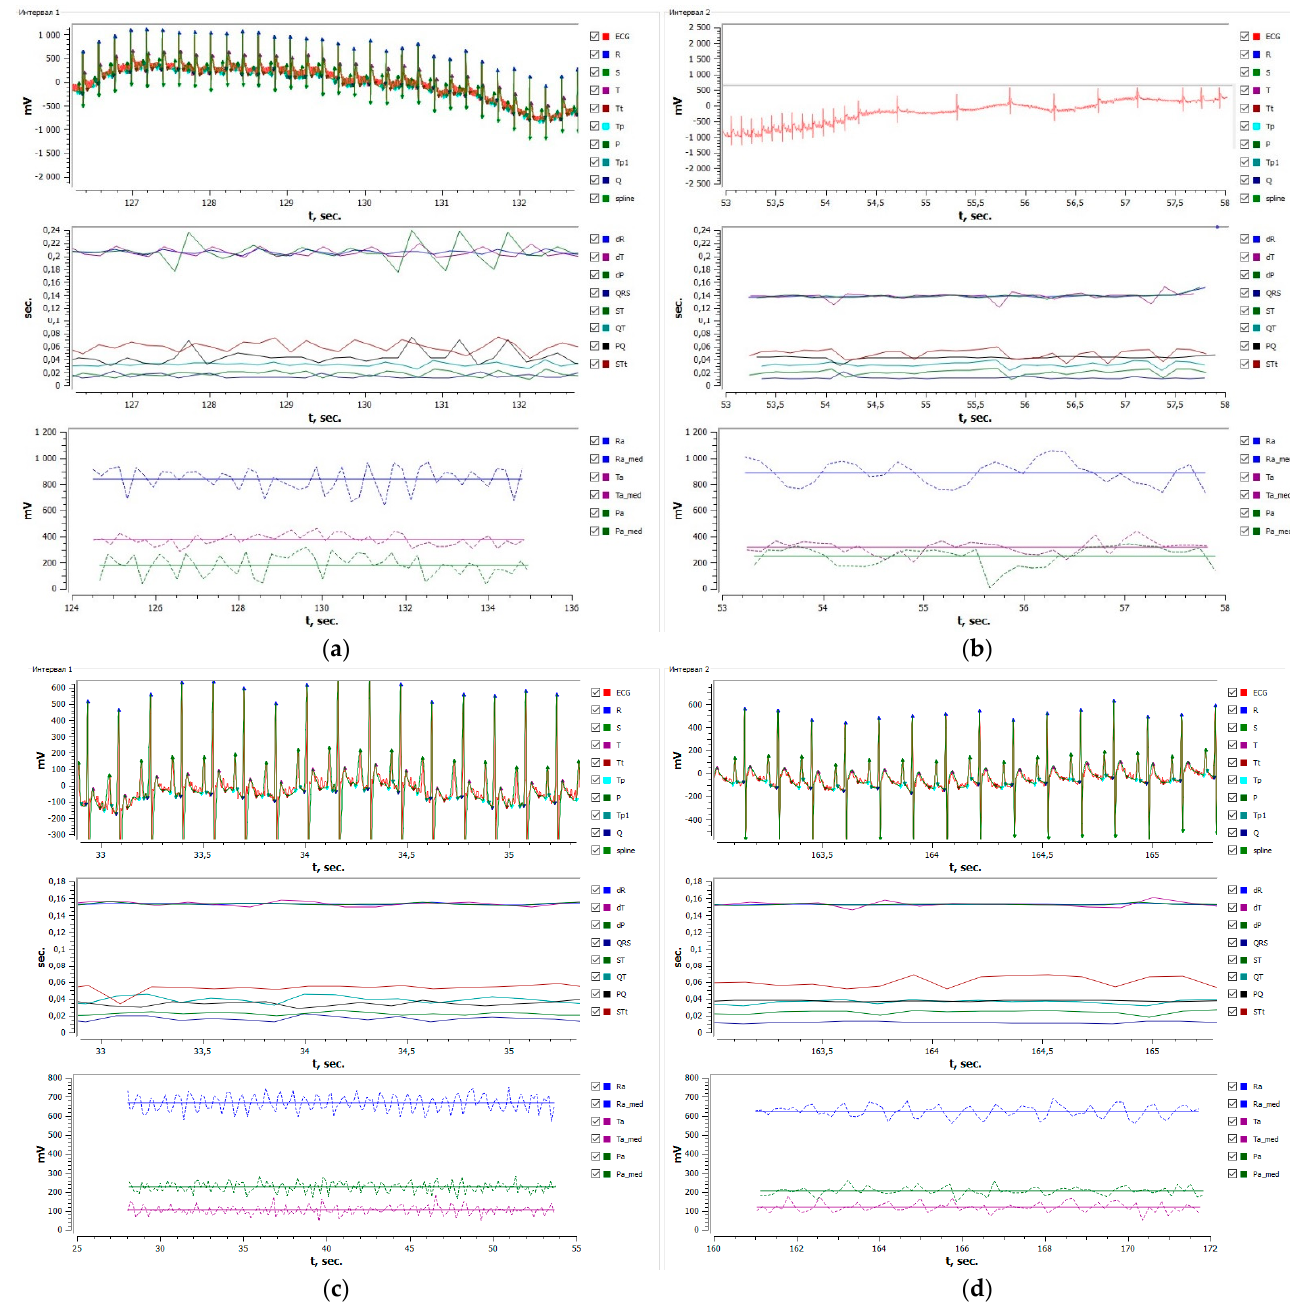
Figure 4. Restoration of ECG in the rat after CaCl 2 injection on the background of compound 1 at a 0.25 mg/kg dose: ( a ) native ECG, ( b ) arrhythmia secondary to CaCl 2 injection, ( c ) ECG after injection of compound 1 , and ( d ) restoration of ECG in the rat when CaCl 2 was injected on the background of compound 1 at a 0.25 mg/kg dose (ED 50 ).